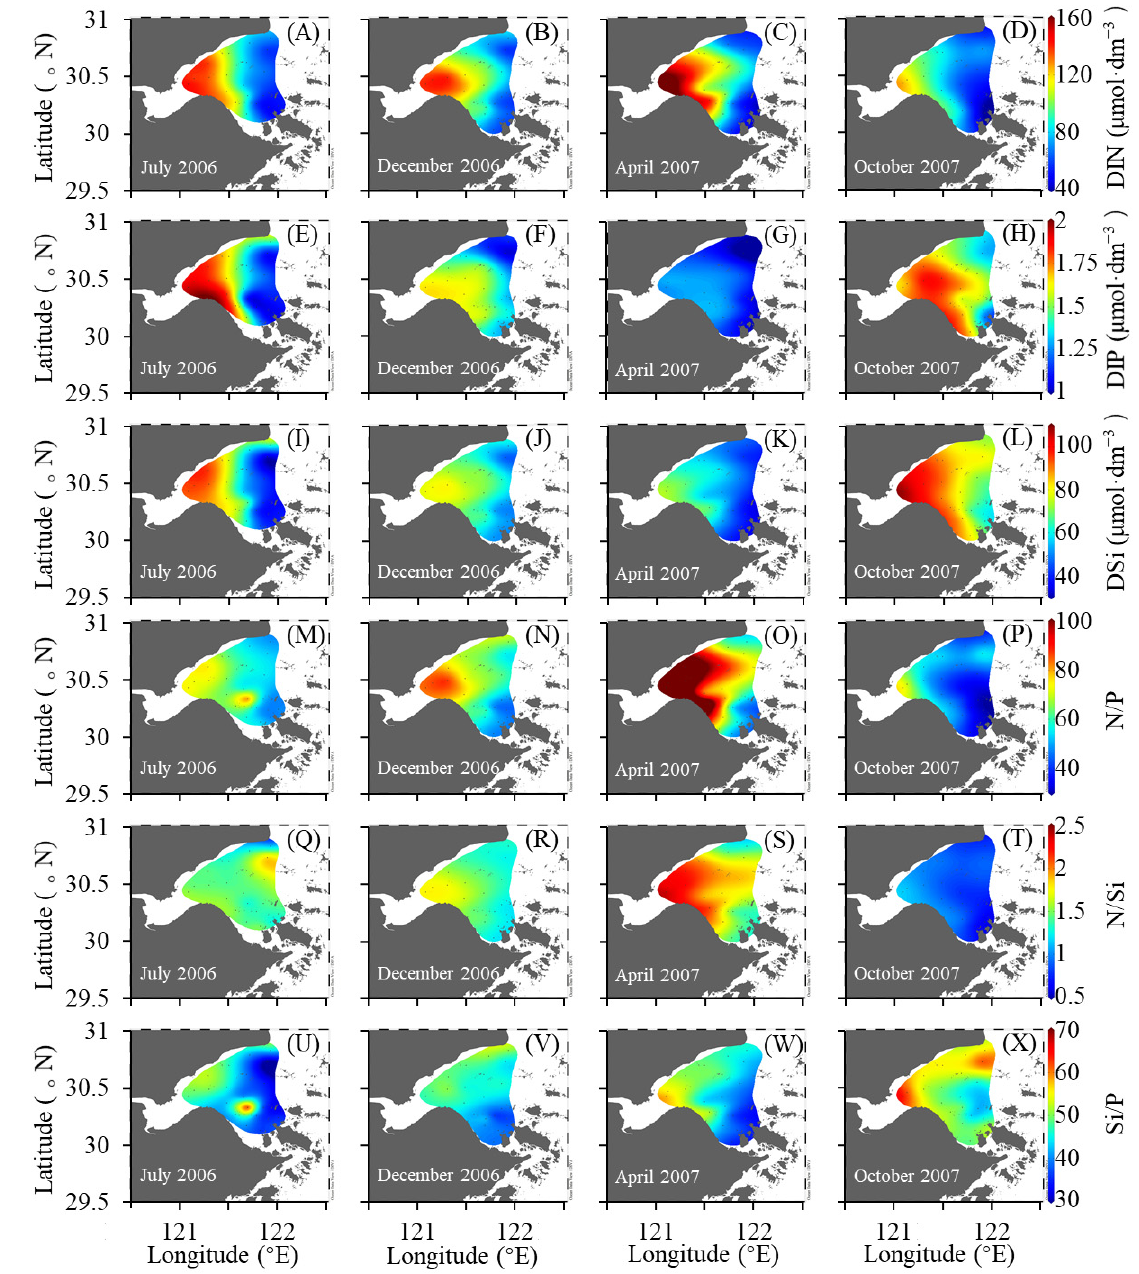
Figure 2. Spatial and temporal variations of ( A – D ) DIN ( μ mol·dm − 3 ), ( E – H ) DIP ( μ mol·dm − 3 ), ( I – L ) DSi ( μ mol·dm − 3 ), ( M – P ) N/P, ( Q – T ) N/Si and ( U – X ) Si/P.